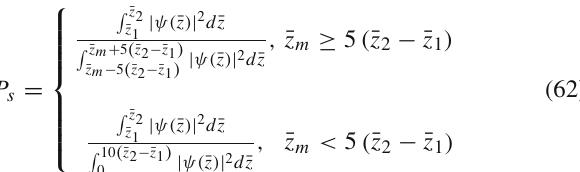
Fig. 17 Theeffectivepotential,therelativeprobability,andwavefunc- tions of the first odd and even KK resonance with ¯ b = 5 and ¯ α = 0 . 016 for case 2